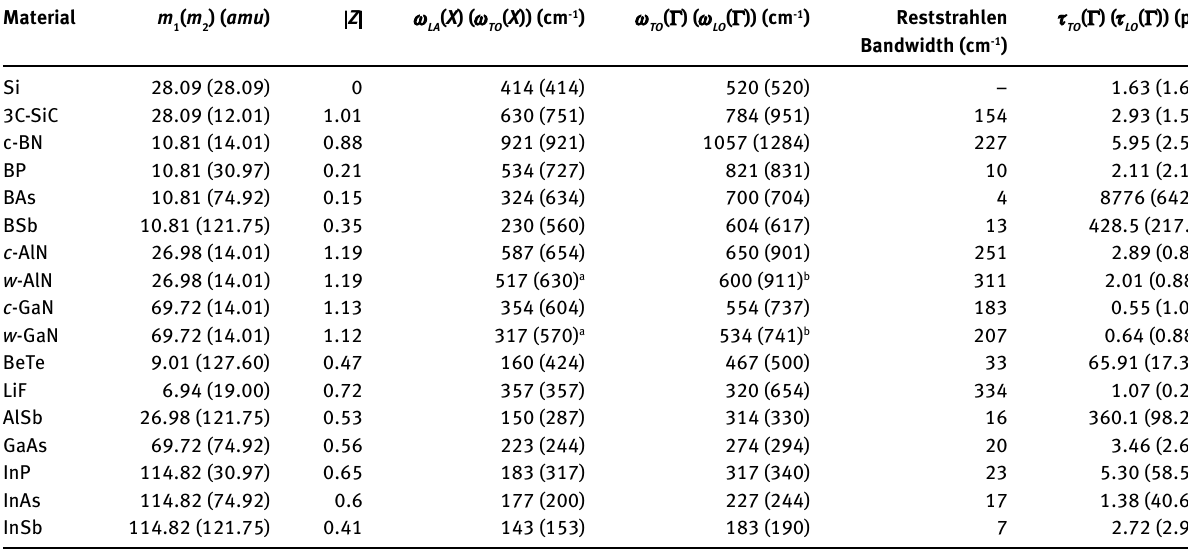
Table 3 Isotope averaged atomic masses and reduced effective charges ( Z ) are given for a variety of